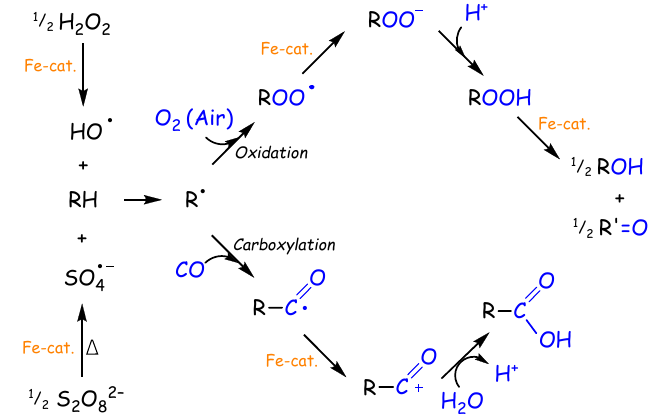
Figure 5. Simplified mechanism for oxidation and carboxylation of alkanes.